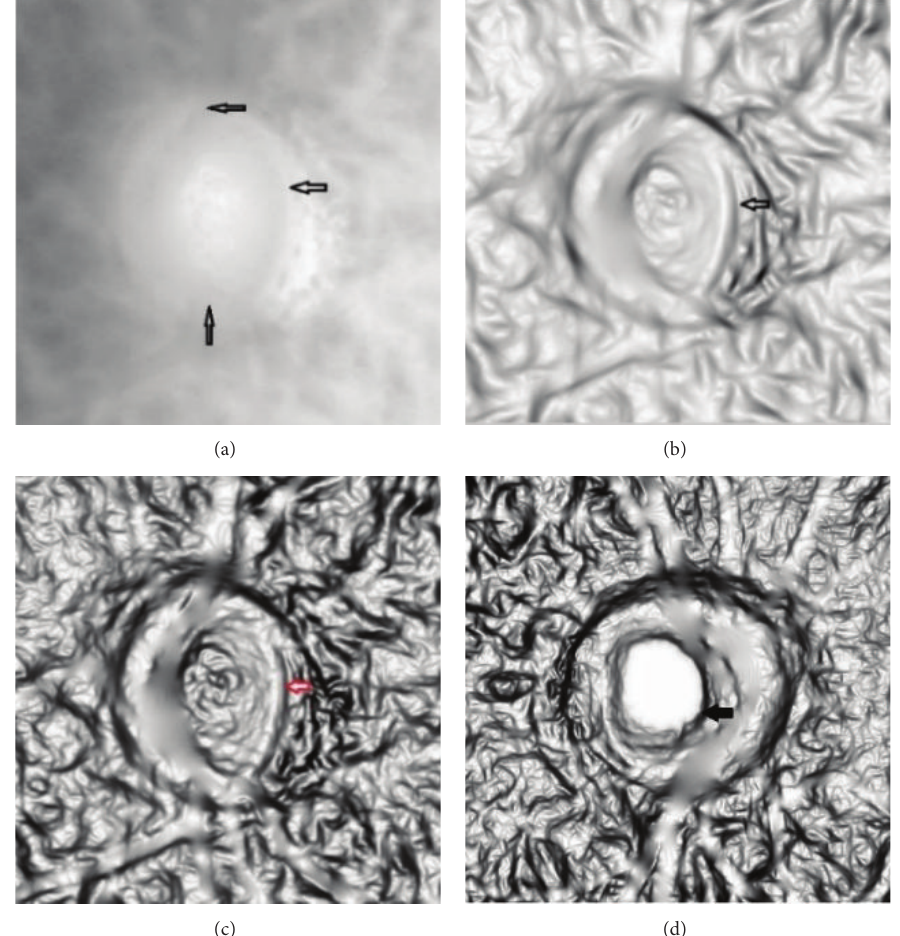
Figure 9: Image texture enhancement. (a) Raw image. The arrow indicates the week edges. (b) Image texture. The arrow indicates the fuzzy edge. (c) Texture enhancement. (d) Faked edges caused by